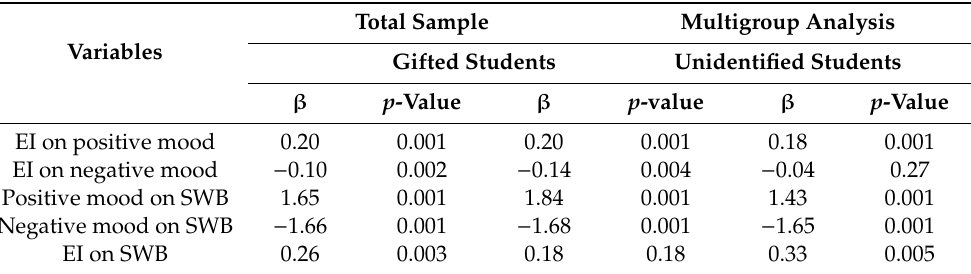
Table 4. Standardized SEM e ff